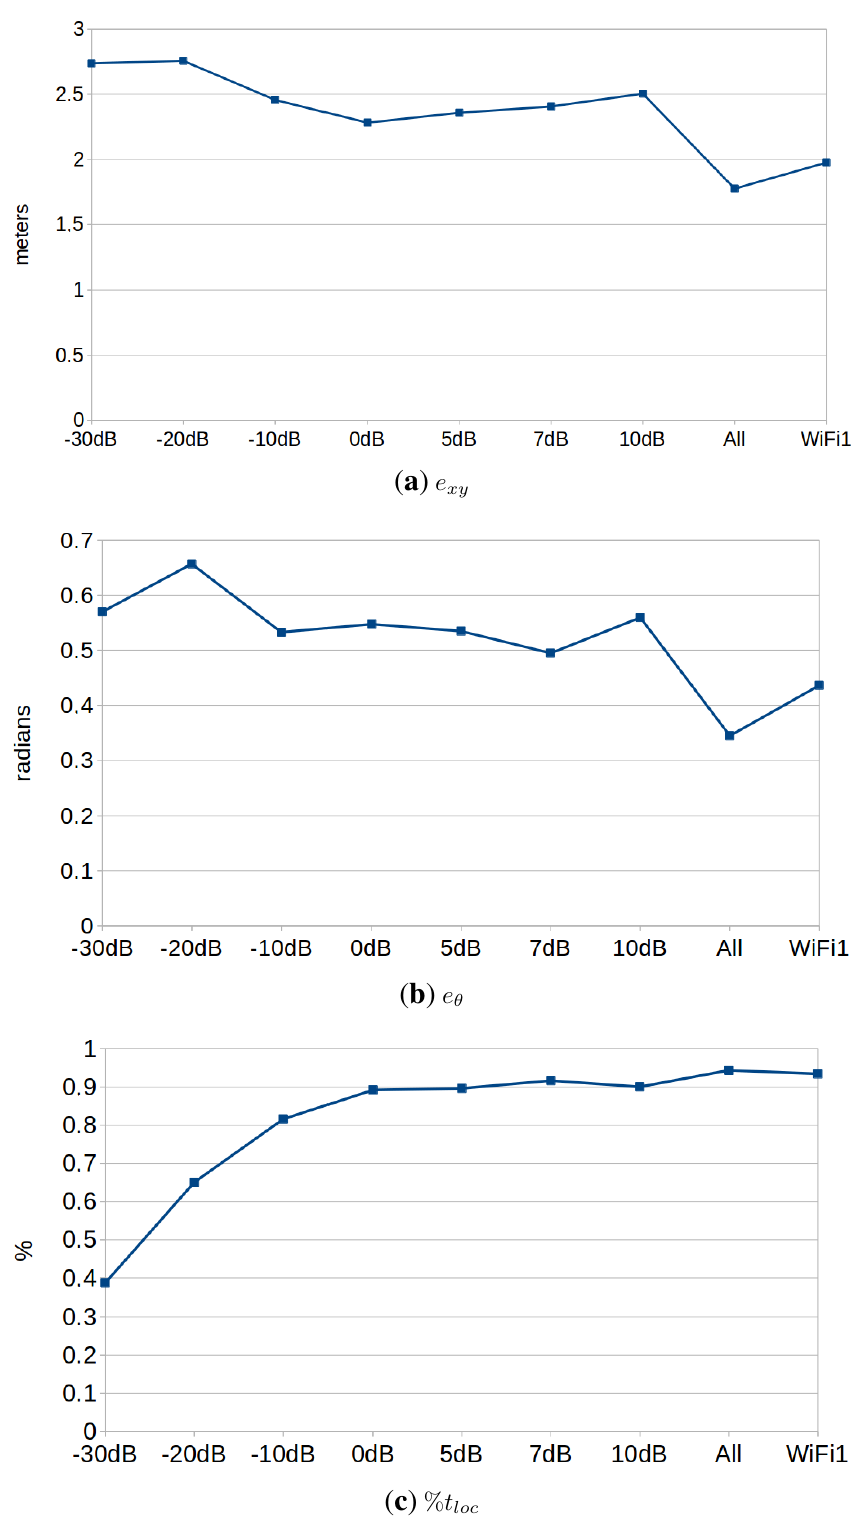
Figure 10. Comparison of the performance of the algorithm using: ( a ) motes with different fixed transmission powers (tagged as − 30 dBm, − 20 dBm, − 10 dBm, 0 dBm, 5 dBm, 7 dBm or 10 dBm); ( b ) motes that change their transmission power periodically (tagged as ‘all’); and ( c ) the WiFi card that performed better in the previous experiment (tagged as WiFi1). We have discarded the results obtained when using a transmission power of − 40 dBm, because the algorithm did not converge most of the